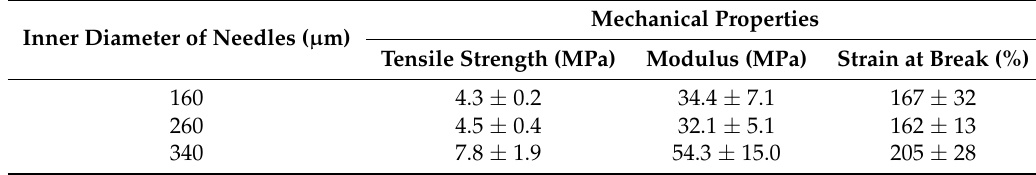
Inner Diameter of Needles ( µ